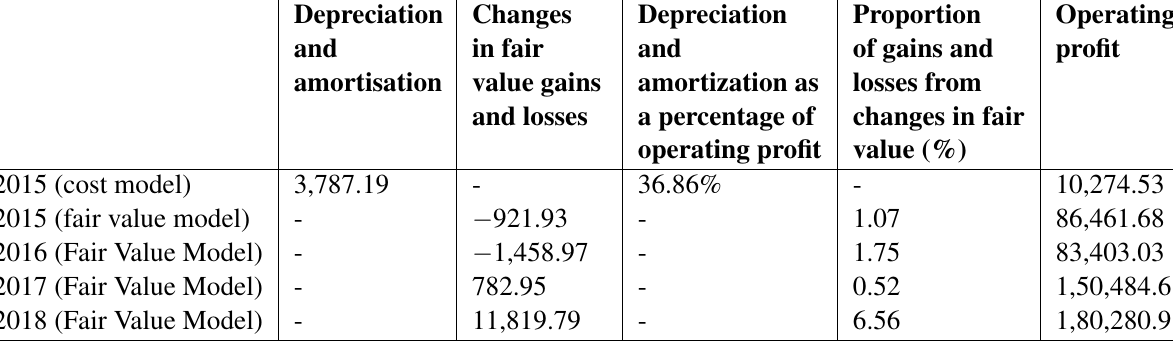
Table 3 A summary of the impact on the income statement after the measurement mode change